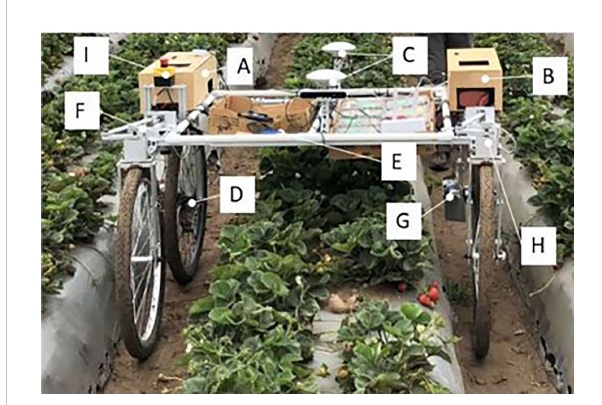
FIGURE 3 Co-robot for on-farm transportation of strawberries: (A, B) control boxes, (C) GPS antennas, (D, G) DC motors, (E) return button, (F) and (H) steer-driving system, (I) emergency